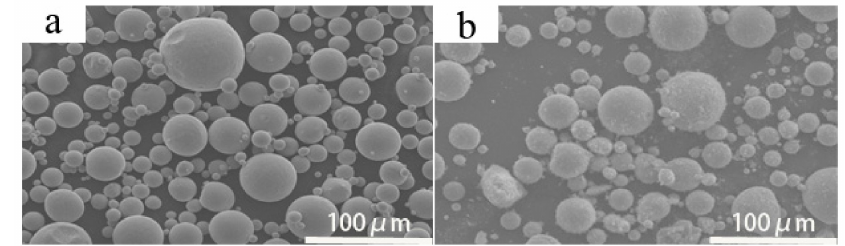
Figure 2. Powder particle morphology: ( a ) cobalt chromium alloy powder morphology and ( b ) morphology of the same powder with 5% Al 2 O 3